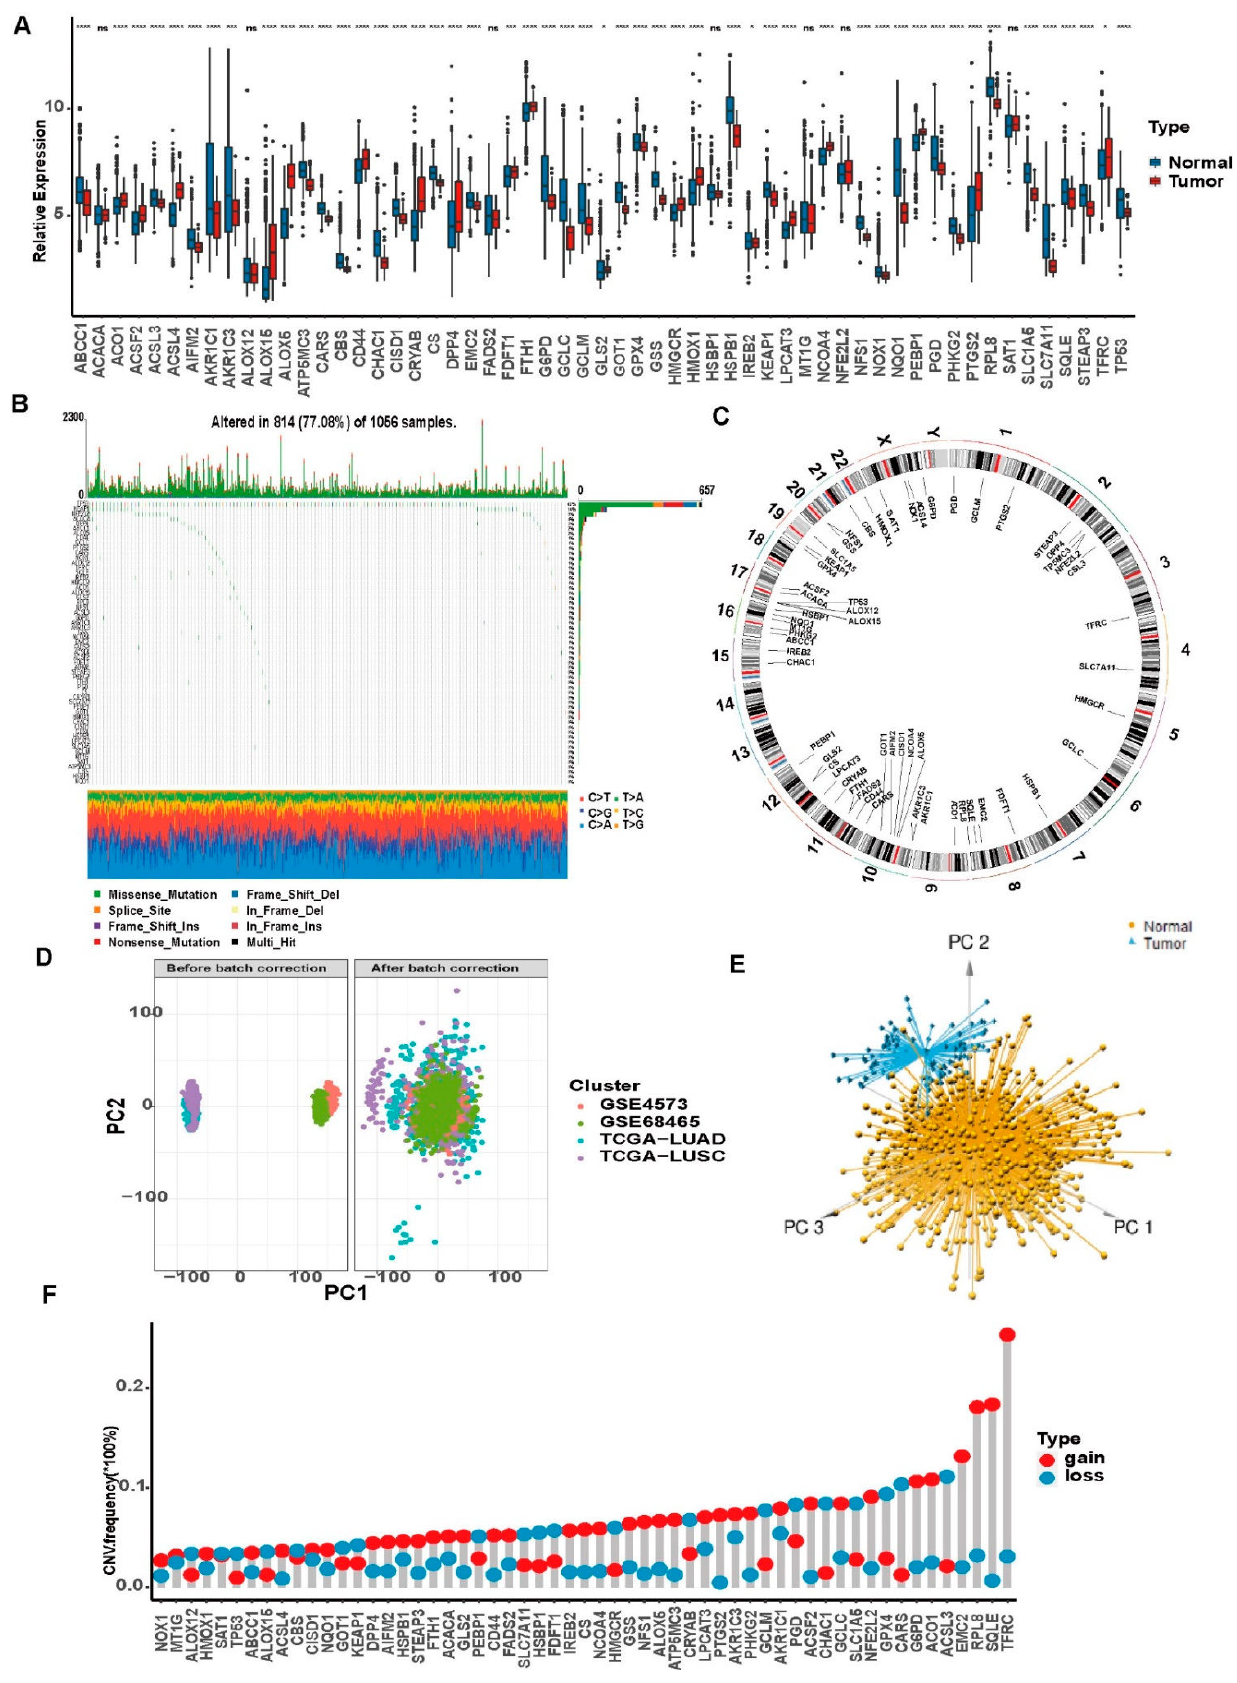
Figure 2. Genetic variation of ferroptosis-related genes. ( A ) The expression level of